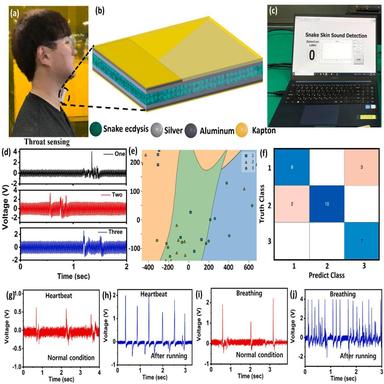
(a) The pictorial image of the vocal vibration sensing. (b) The structure of the sensing device. (c) The pictorical image of the machine learning system based on SVM. (d) The generated output from the throat vibrations of the different pronunciations. (e) Feature map including decision boundary and test data, and (f) confusion matrix of the throat sensing test from different pronunciations. The heartbeat sensing in (g) the normal conditions and (h) after running. The breathing in (i) the normal conditions a